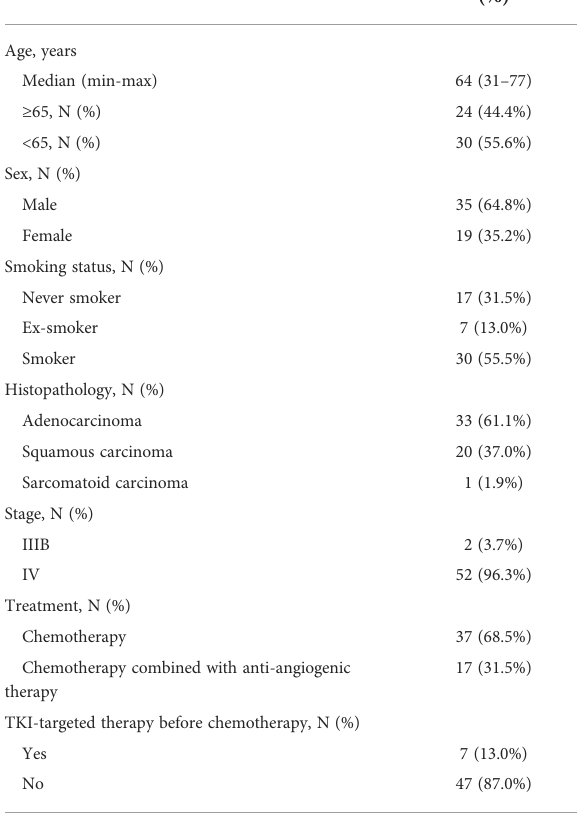
TABLE 1 Clinicopathological characteristics of the 54 NSCLC included in ef fi cacy analysis.